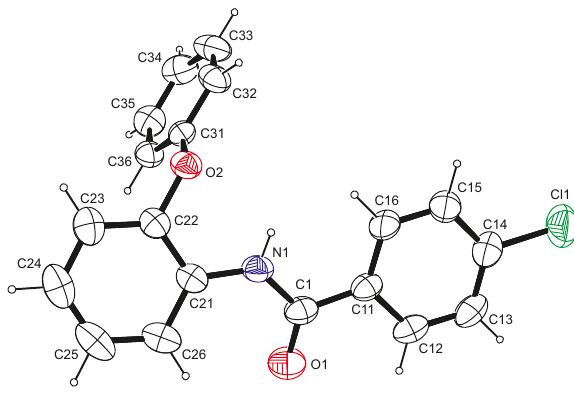
Table  : Data collection and